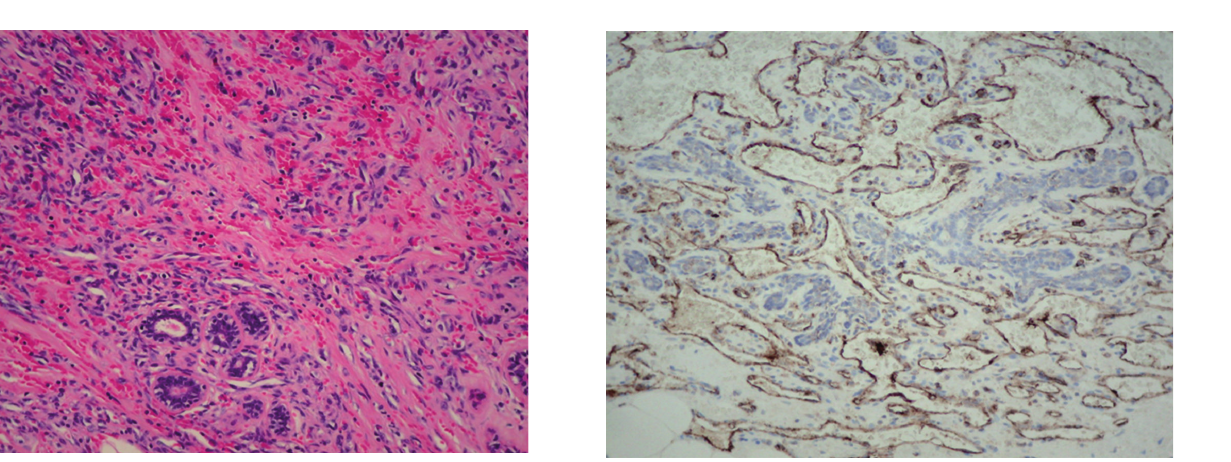
Figure 2: CD31 immunohistochemistry in left breast’s angiosar- coma (200x).